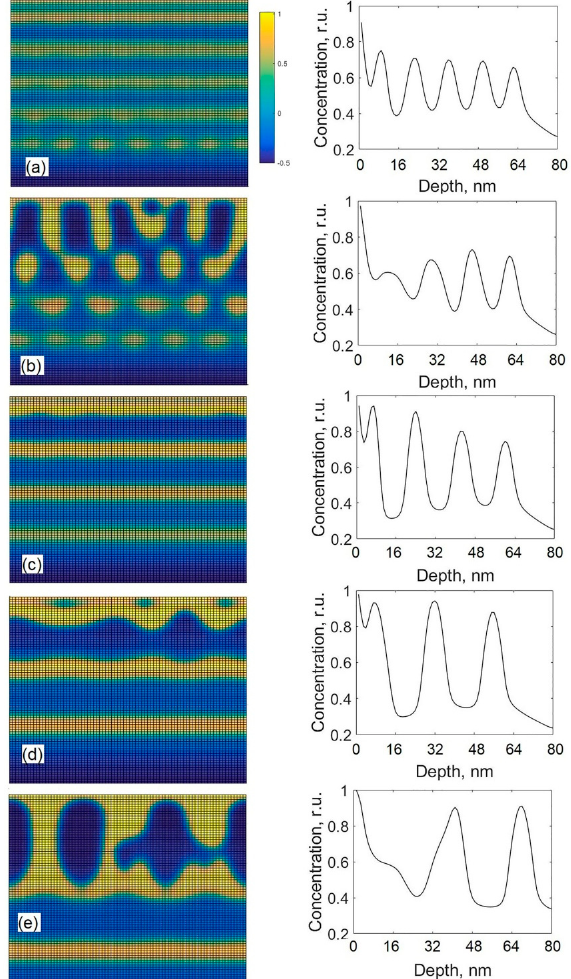
Figure 7. Cross-sectional views and depth profiles of carbon obtained by the modified model using different diffusion coefficients: 2.0 × 10 − 18 m 2 /s ( a ), 3.0 × 10 − 18 m 2 /s ( b ), 4.1 × 10 − 18 m 2 /s ( c ), 8.5 × 10 − 18 m 2 /s ( d ), 1.3 × 10 − 17 m 2 /s ( e ).